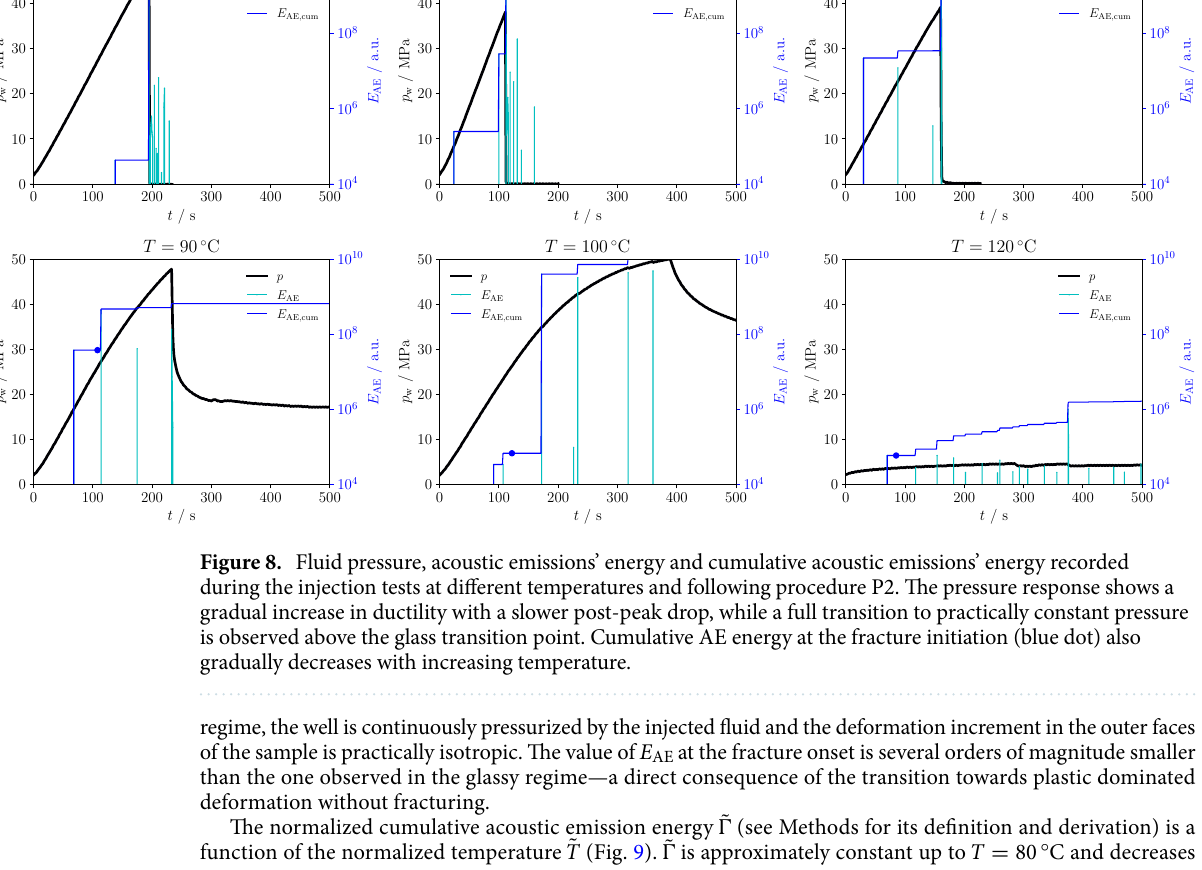
Figure 7. Post-mortem samples of PMMA at different temperatures following P2 experimental procedure (see Methods). A single planar mode-I hydro-fracture propagated up to T T 100 ◦ C where only large visco-plastic deformation around the wellbore was observed. ≥